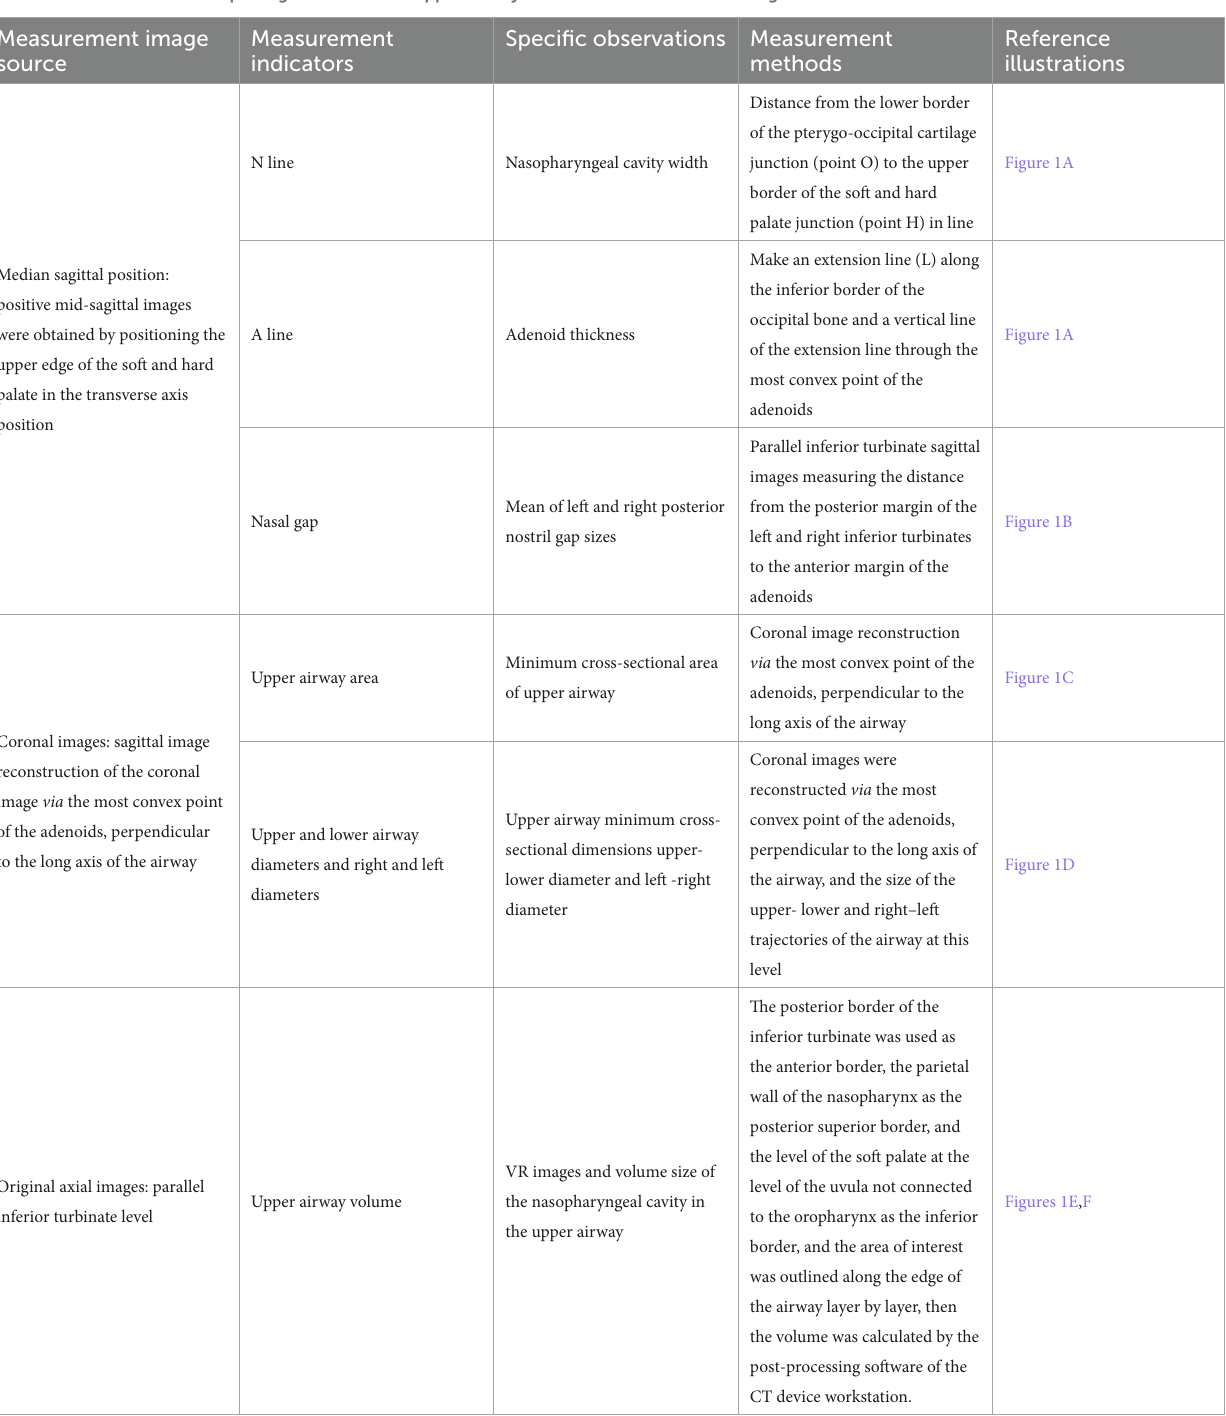
perpendicular to the examination bed surface, the midsagittal position of the head and body coincident with the table top. All children were fixed with head rest to avoid artifacts caused by head movement Cases with image artifacts such as swallowing and respiratory movement were excluded. The scanned part was the nasopharynx, from the upper limit of the nasopharyngeal apex to the lower limit of the epiglottis. All children were examined by low-dose scanning protocol: tube voltage 100KV, Care Dose 4D automatic tube current technology and iterative reconstruction algorithm, scanning layer thickness